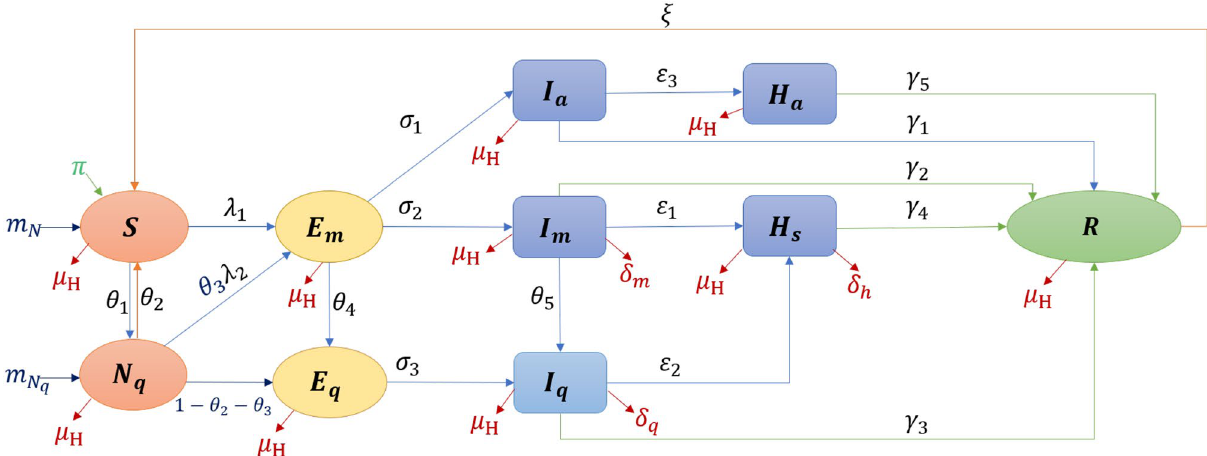
Figure 1. Susceptible-Exposed-Infectious-Hospitalised-Recovered (SEIHR)